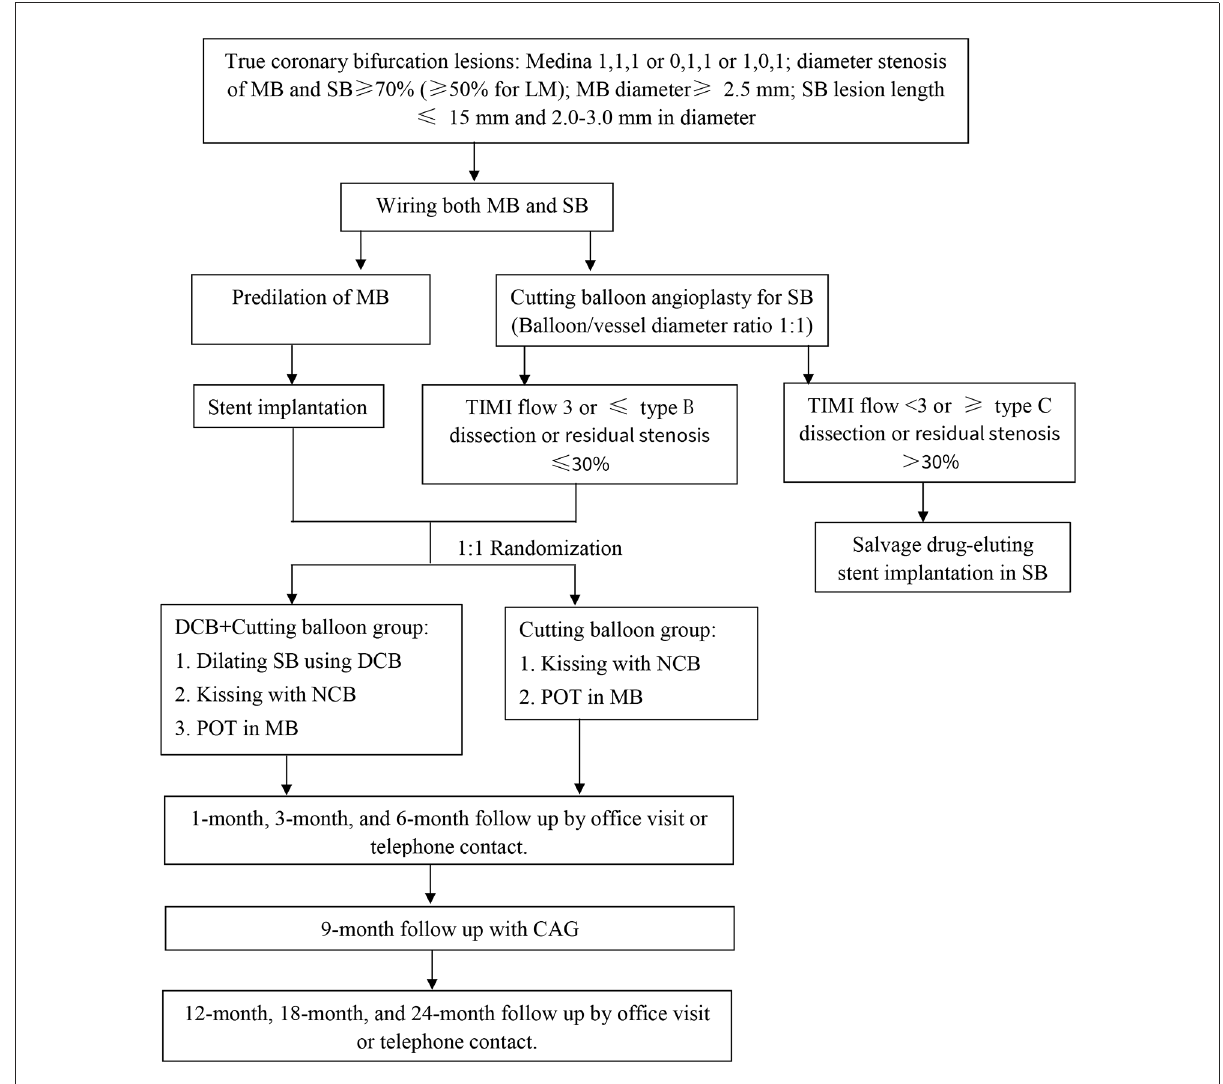
FIGURE1 Flowchart of the clinical trial design. MB, main branch; SB, side branch; LM, left main; TIMI, thrombolysis and thrombin inhibition in myocardial infarction; DCB, drug-coated balloon; NCB, non-compliant balloon; POT, proximal optimization technique; CAG, coronary